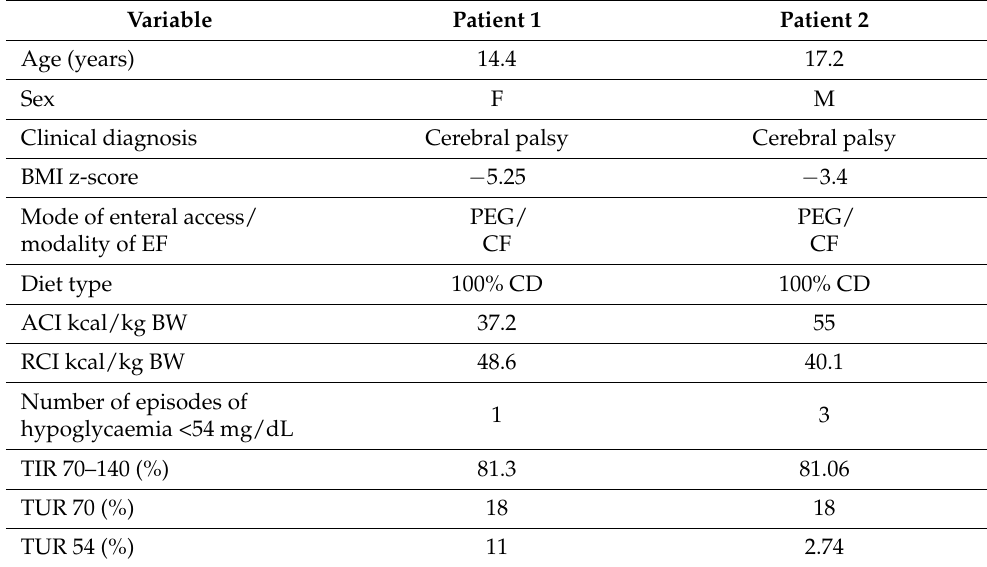
Table 4. The characteristics of patients with severe (<54 mg/dL) hypoglycaemia.